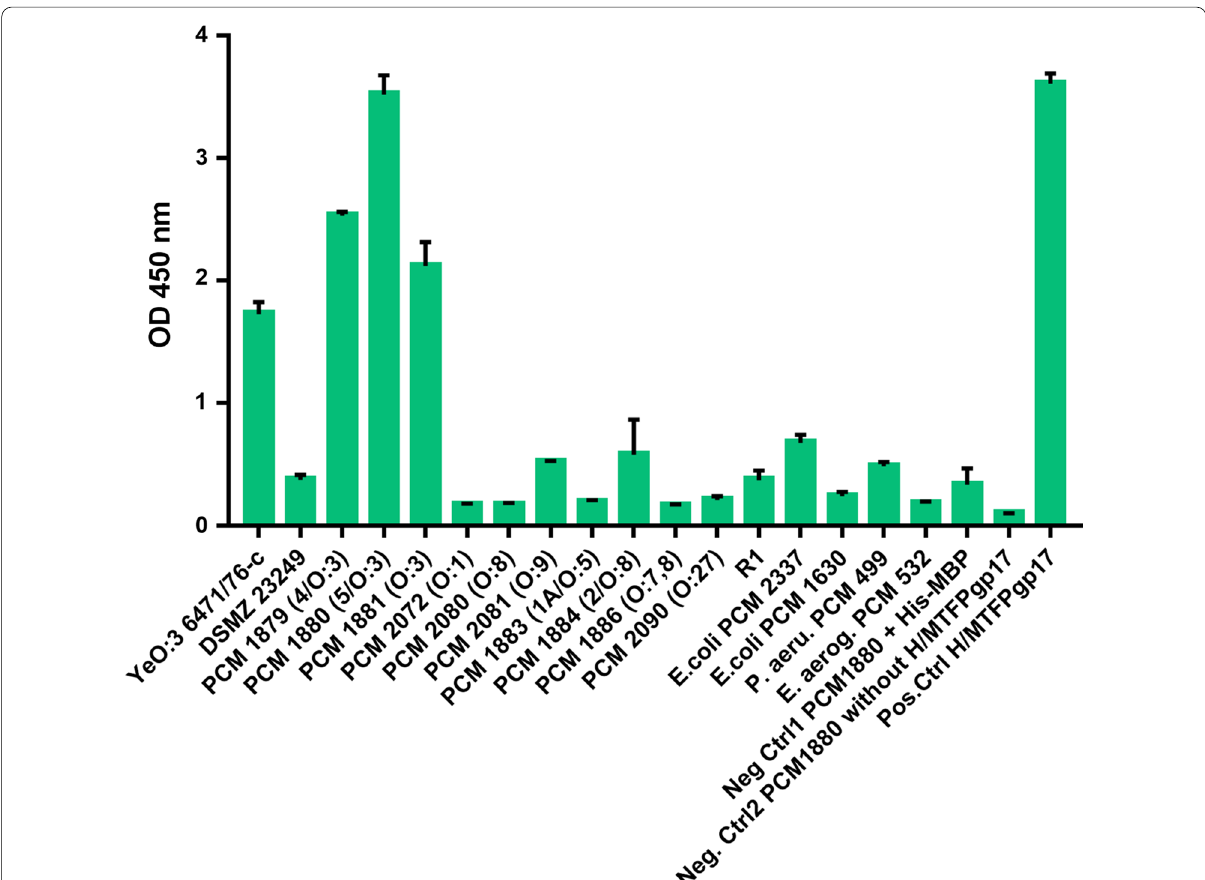
Fig. 2 H/MTFP‑Gp17—based ELISA for specific detection of YeO:3 (10 5 CFU/ml). The bound H/MTFP‑Gp17 was detected by HRP‑conjugated IgG anti‑HisTag monoclonal antibody. The color development was measured at 450 nm on a microplate reader. SD was calculated from 3